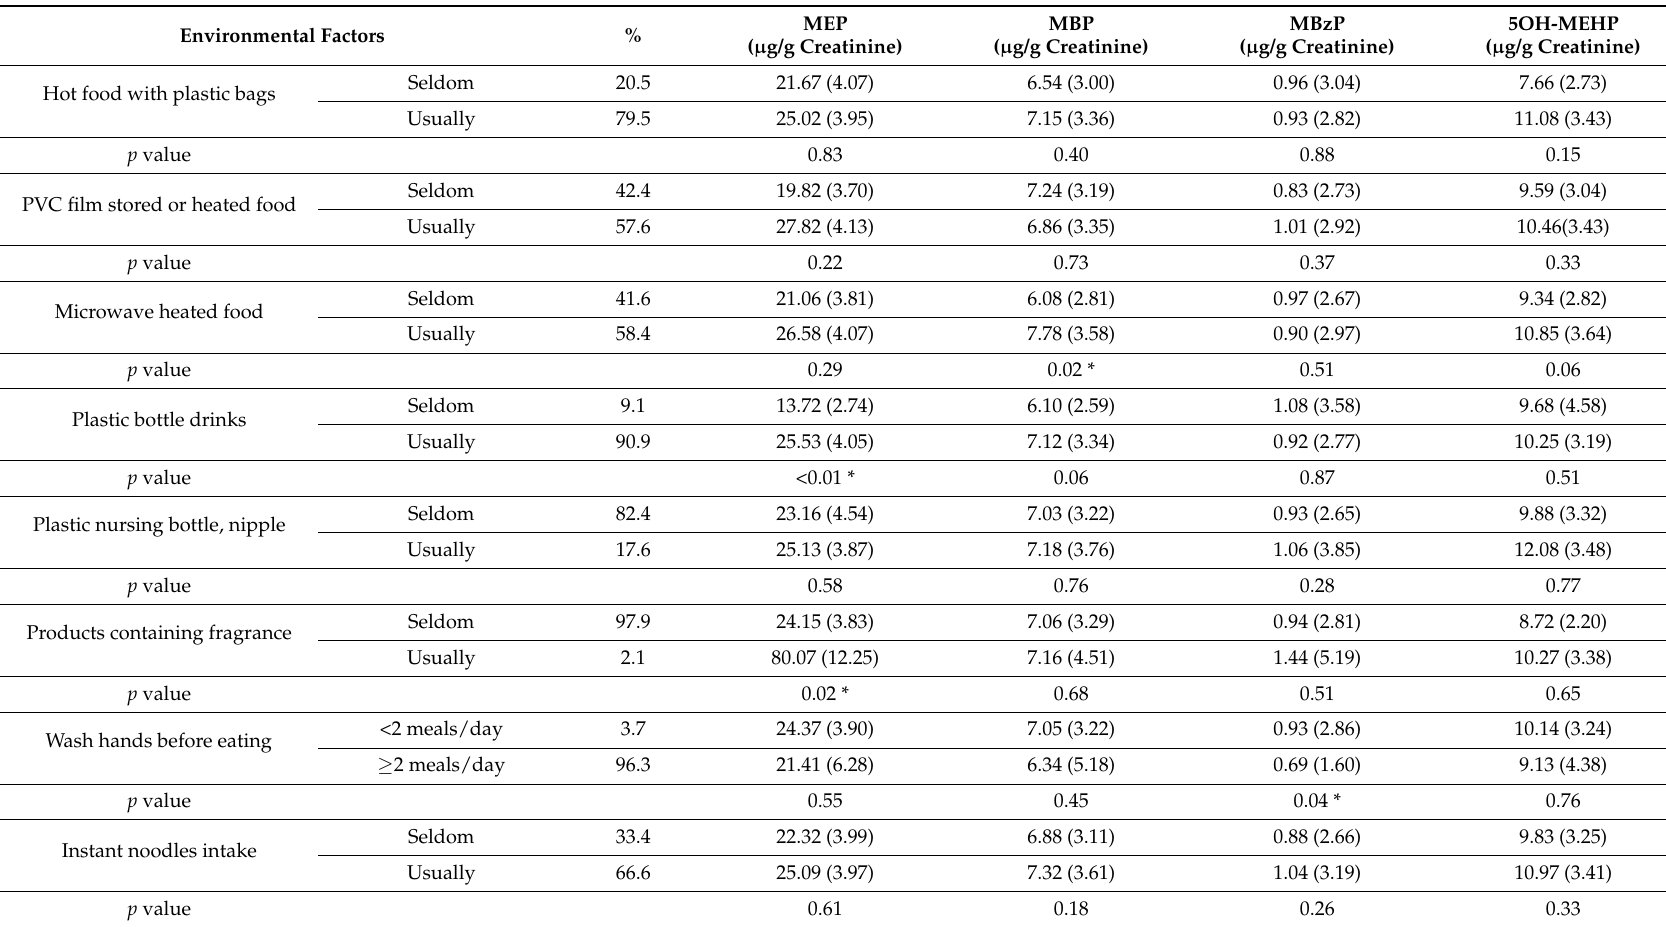
Table 2. Environmental factors of the study population in terms of geometric means (s.e.) of urine phthalate metabolites concentrations in 2010 ( n = 453). Environmental